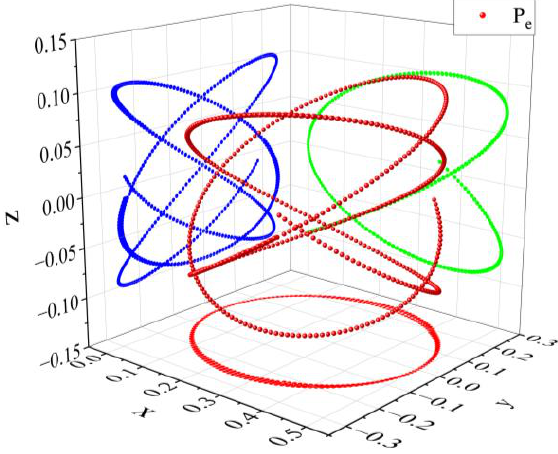
Figure 19. Trajectory of the end point of the offshore gangway without compensation control.